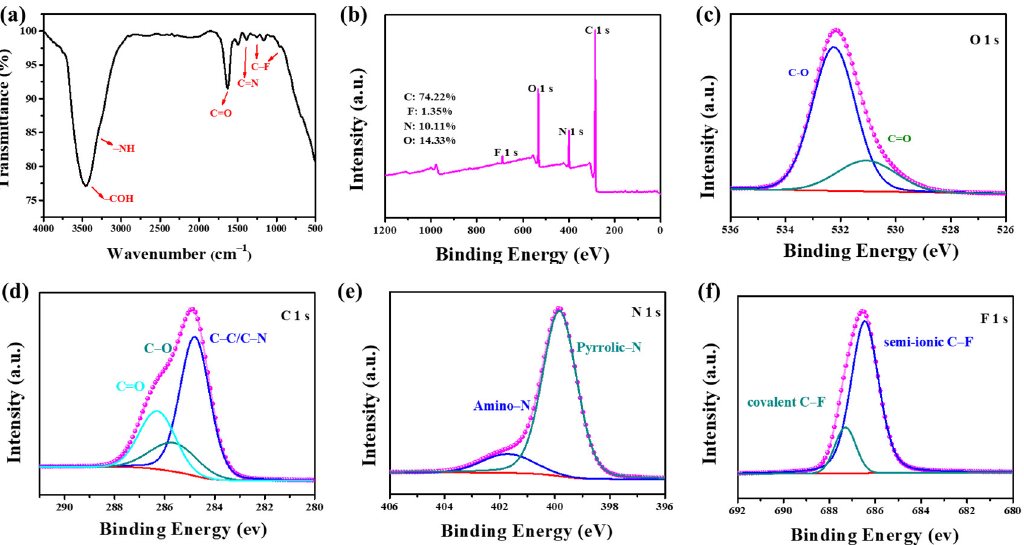
Figure 2. ( a ) FT-IR spectrum and ( b ) XPS survey spectrum of blue emissive CDs, and the corresponding high-resolution ( c ) O 1 s, ( d ) C 1 s, ( e ) N 1 s, and ( f ) F 1 s XPS spectra.